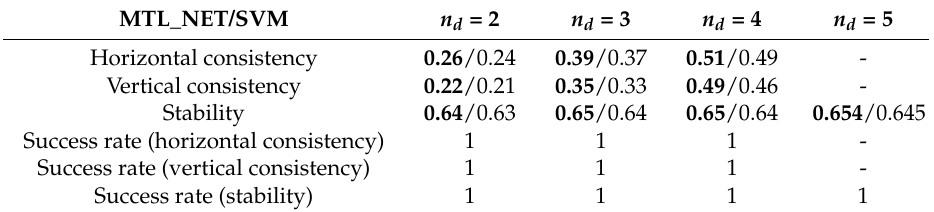
Figure 3. Horizontal and vertical model consistency. To analyze the consistency of a given machine-learning algorithm against the cross-dataset variability, we quantified the horizontal ( a ) and vertical ( b ) model consistency for different numbers ( n d ) of training datasets. Specifically, horizontal consistency quantified the similarity between models trained using the same number of datasets, and vertical consistency quantified the pairwise similarity of models, where one was trained using all datasets and the other was trained using less datasets. Stratified 100-fold bootstrapping procedure was applied to quantify the variation of the consistency. Table 1. Mean consistency, stability, and success rate across the number of training sets, n d